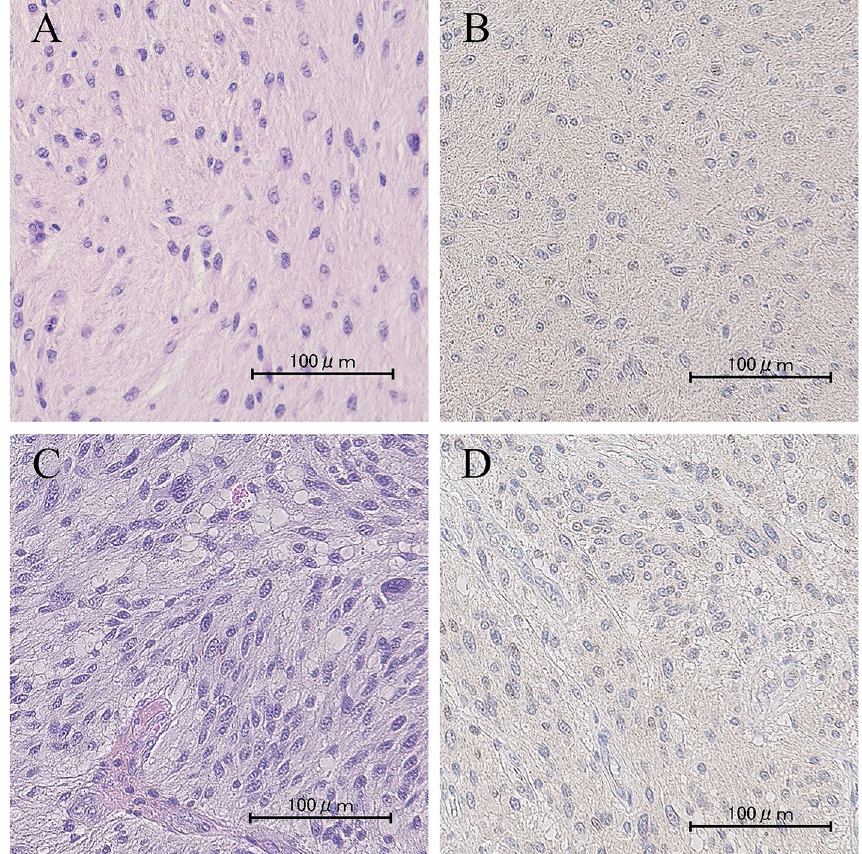
Figure 4. Histologic and immunohistochemical findings. ( A ) HE staining of initial surgery specimen showing diffuse infiltration of atypical astrocytes without necrosis or micro vascular proliferation. ( B ) IHC staining of IDH1 R132H of initial surgery specimen showing negative results. ( C ) HE staining of second surgery specimen showing proliferation of atypical glial cells with mitoses and microvascular proliferation. ( D ) IHC staining of IDH1 R132H of second surgery specimen showing negative results. Scale bars: 100